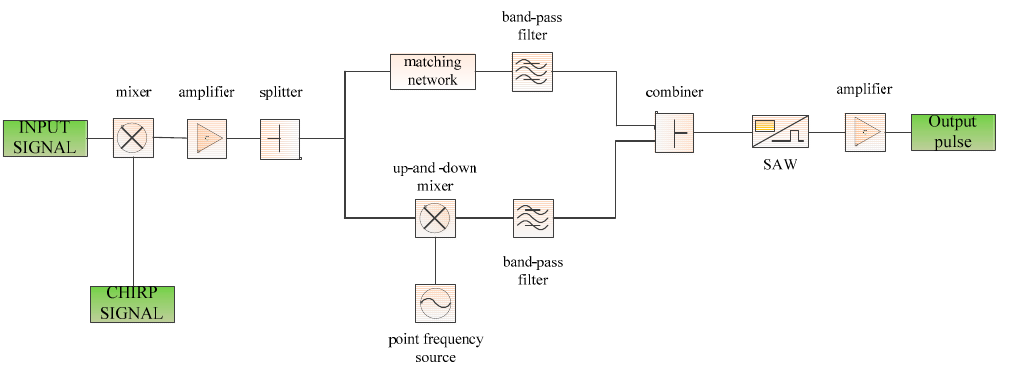
Figure 4. The structure of the frequency conversion single M(l)-C(s) (FCS M-C) arrangement.